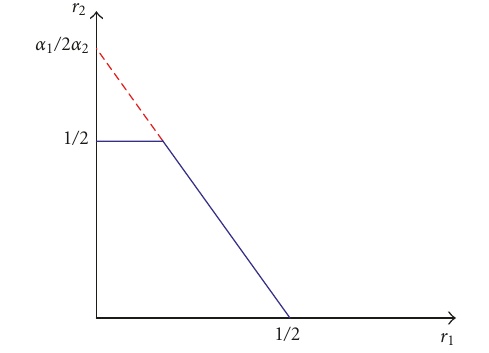
Figure 2: SNR capacity region for the case where α 1 > α 2